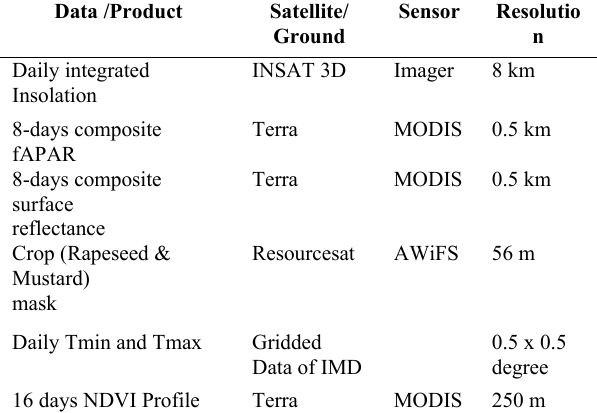
Table 2. Data details for rapeseed & mustard yield estimation using semi-physical model